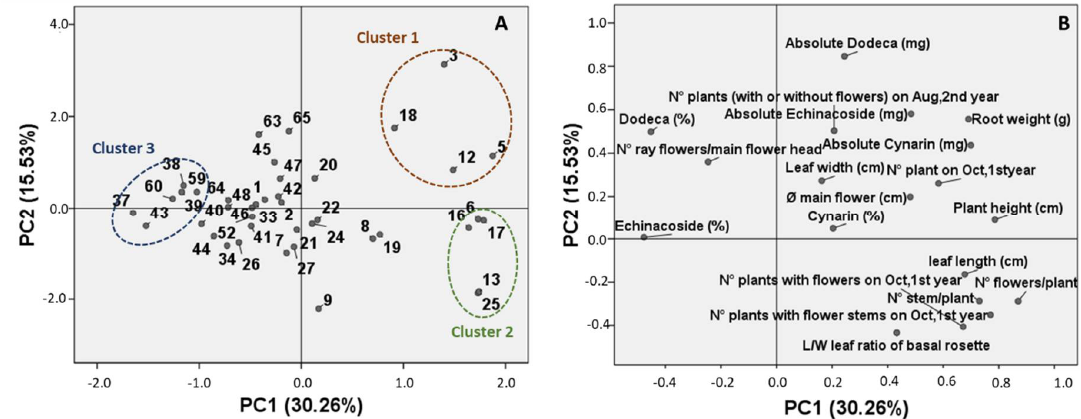
Figure 4. Principal Component Analysis (PCA) of 41 authentic E. angustifolia accessions based on phytochemical, agronomic and morpho-quantitative characteristics. ( A ): score plots of the different accessions; ( B ): loading plots of the variables.